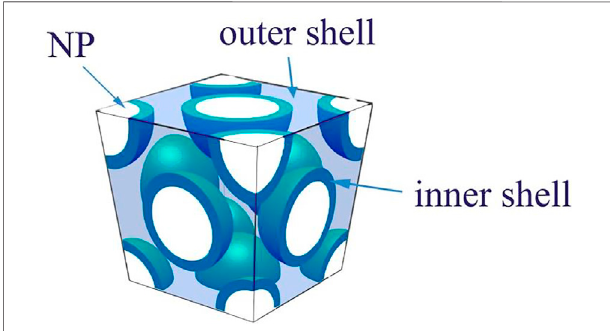
FIGURE 6 | Simulation geometry in the fi nite element